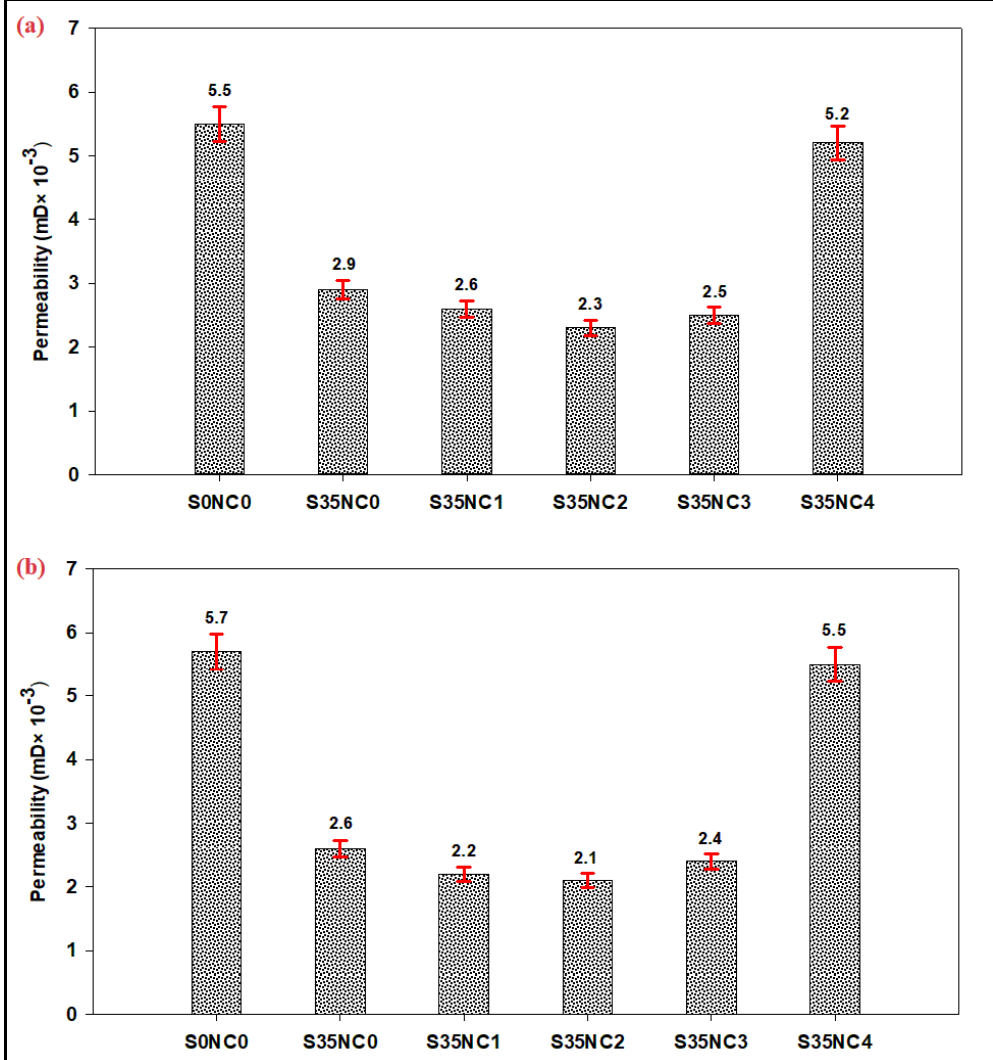
Figure 5. The permeability of the samples after experiencing a condition similar to one cycle of steam injection at 300 °C for 3 days after being cured at 38 °C for ( a ) 4 days ( b ) 25 days. The total curing times are ( a ) 7 days and ( b ) 28 days.